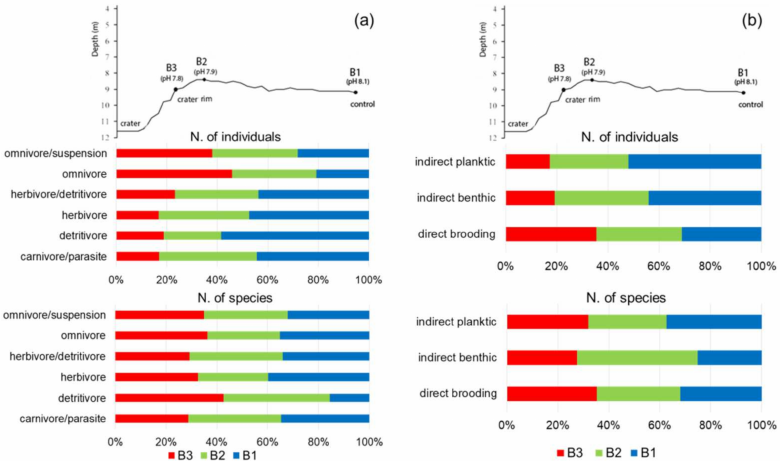
Figure 6. Relative proportion of the number of individuals and species for: ( a ) different feeding guild categories; ( b ) different reproductive/developmental types (indirect planktic, indirect benthic, and direct brooding) along the OA gradient off the Bottaro crater